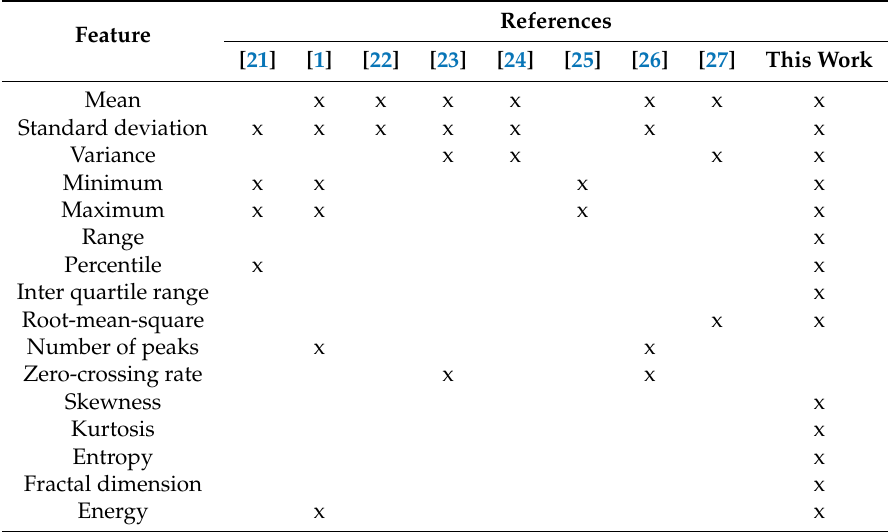
Table 2. Common features for sensor position